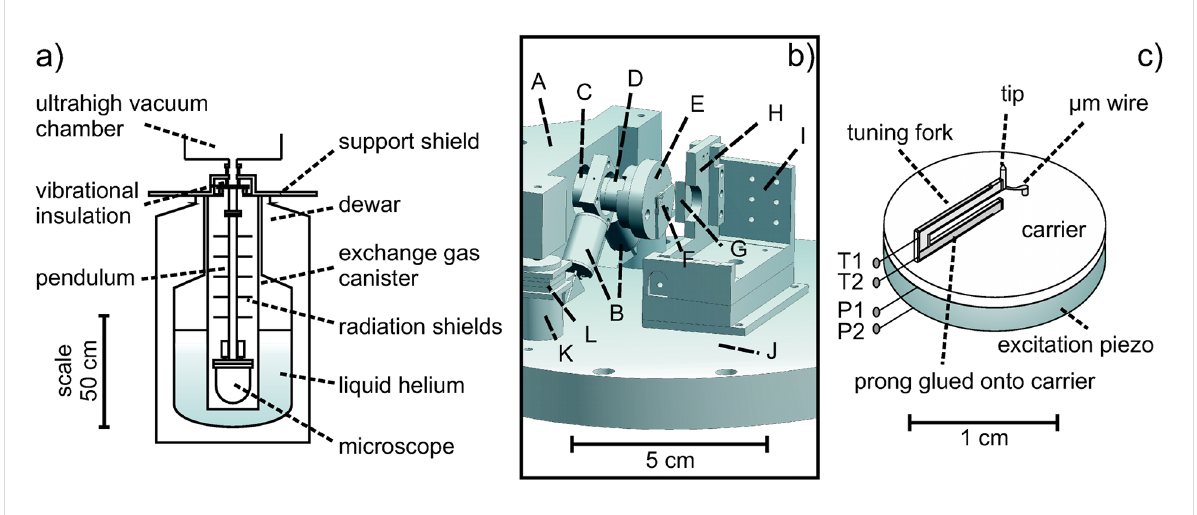
Figure 2: Experimental setup. a) Schematic of an Eigler-style bath cryostat. b) The walker unit is situated on three shear stack piezos for the coarse approach. The x , y and z piezos are used during the scan process. The tuning fork is located opposite the sample (only half of the sample is drawn to keep the view free to the sensor carrier). Schematic of the microscope on its support stage: (A) walker unit, (B) x , y piezo and (C) z piezo of the tripod scanner unit, (D) z dither piezo, (E) sensor carrier, (F) tuning fork assembly, (G) sample (not fully drawn), (H) sample holder (not fully drawn), (I) sample stage (not fully drawn), (J) microscope stage, (K) walker support and (L) shear stack piezos. The base plate has a diameter of 10 cm. c) The NC-AFM/STM tuning fork sensor is glued onto the carrier made of MACOR. Contacts P1 and P2 are the contacts of the excitation piezo. The signal from the tuning fork is detected via contact T1 and T2. The µm wire attached to the tip conducts the tunneling current.